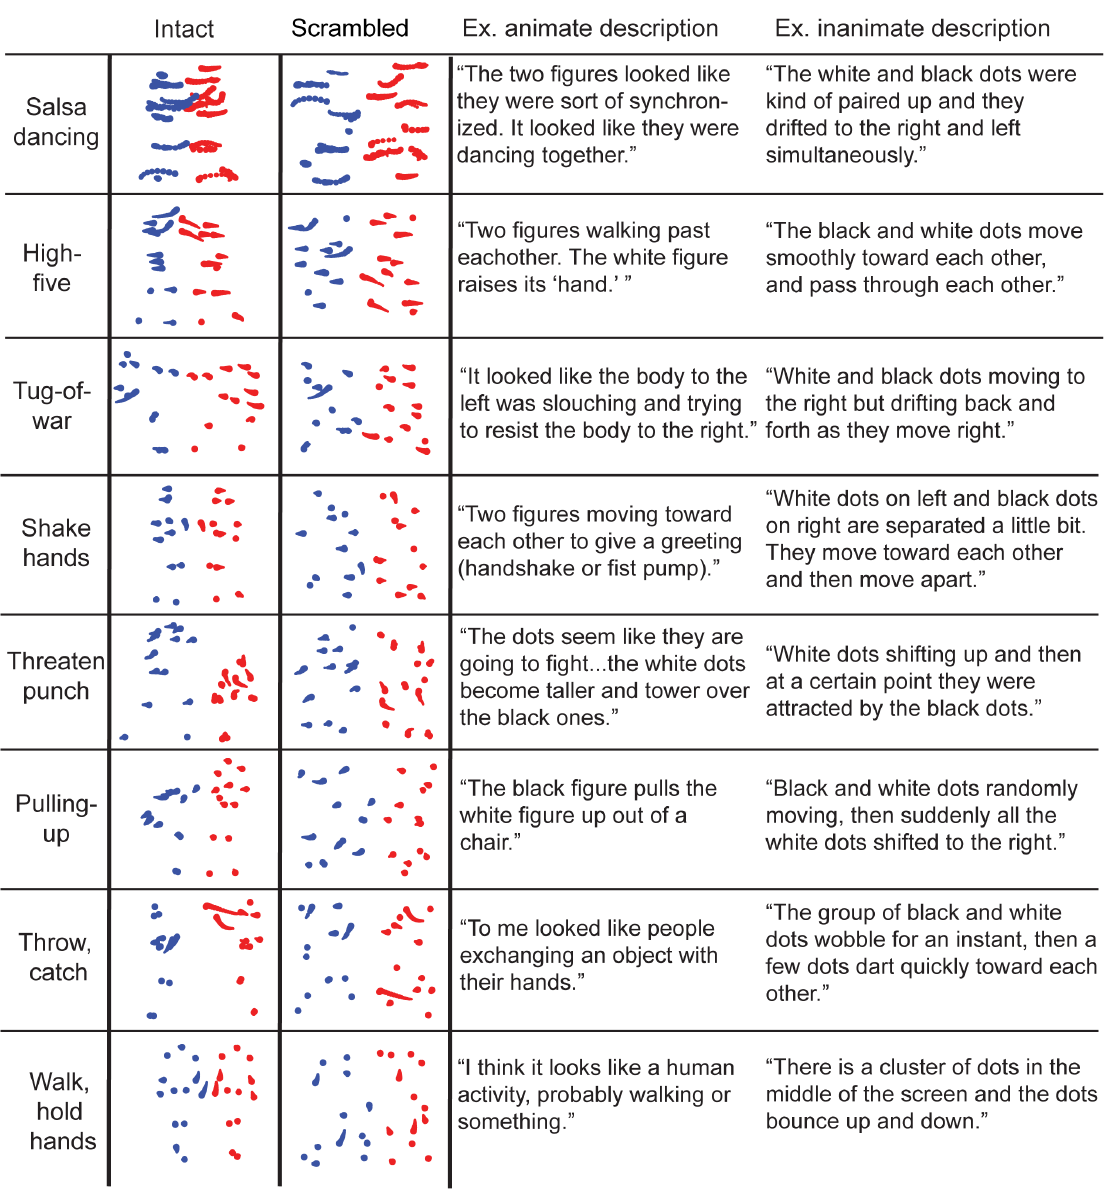
Figure 1. Schematic depiction of each type of interactive display (rows) with and without intact human body form, and examples of written responses. The stimuli in the first column are spatially intact for demonstration purposes, but the stimuli in the experiment were spatially scrambled versions of these animations (second column). For visualization, one dancer is colored in red dots and the other in blue dots. Dot size decreases for time points further in the past. The third and fourth columns include examples of free responses from representative participants that spontaneously used animate (third column), and inanimate (fourth column) descriptions.